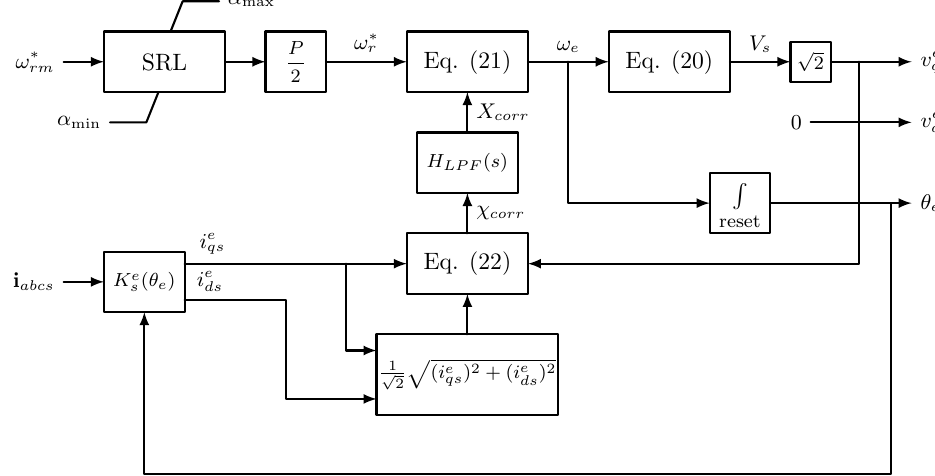
Figure 5. Block diagram of the compensated volts-per-hertz control algorithm.